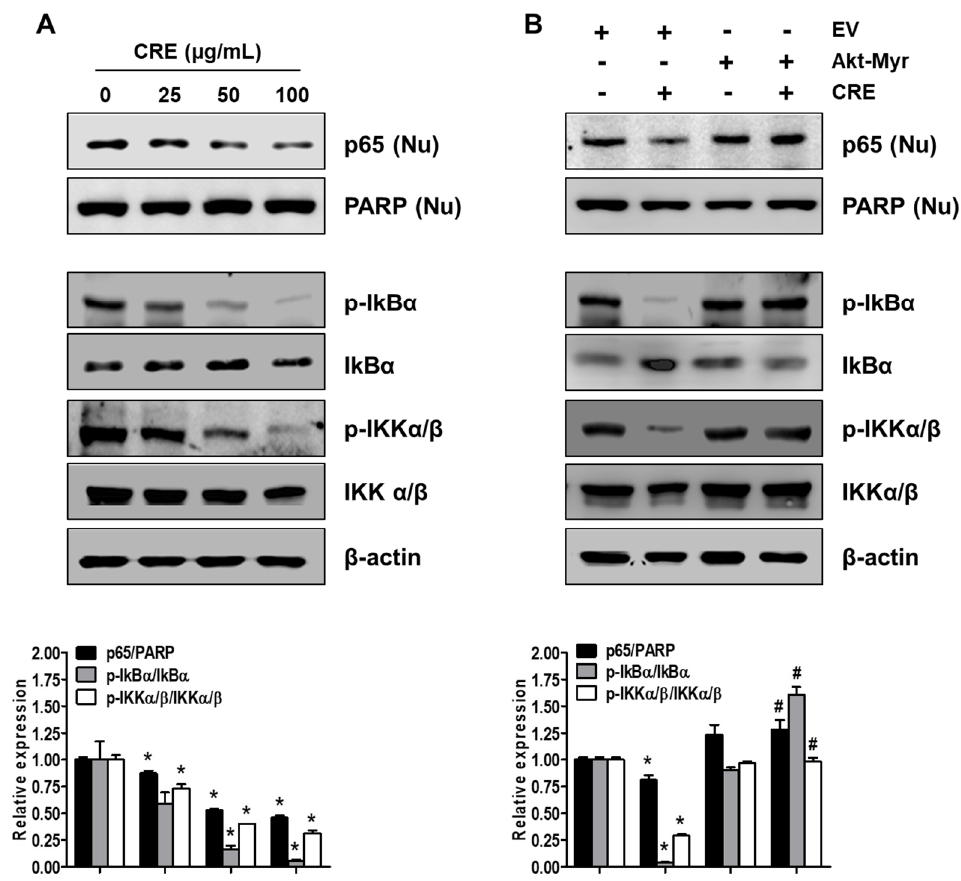
Figure 6. Effect of CRE on the NF-kB activation in endometriotic cells. Nuclear (Nu) and whole cellular proteins were isolated from the cells ( A ) treated with CRE (25, 50 and 100 µg/mL) for 8 h and ( B ) transfected with EV or Akt-Myr. The levels of p65 (Nu), p-IkB α , IkB α , p-IKK α / β and IKK α / β were detected by western blot analysis using specific antibodies. PARP and β -actin were used as an internal control for nuclear fractions and whole cell lysates, respectively. Data are shown as mean band density. Data are presented as the means ± SD of three independent experiments; * p < 0.05 as compared with the control group, and # p < 0.05 as compared with EV-transfected CRE treatment group.